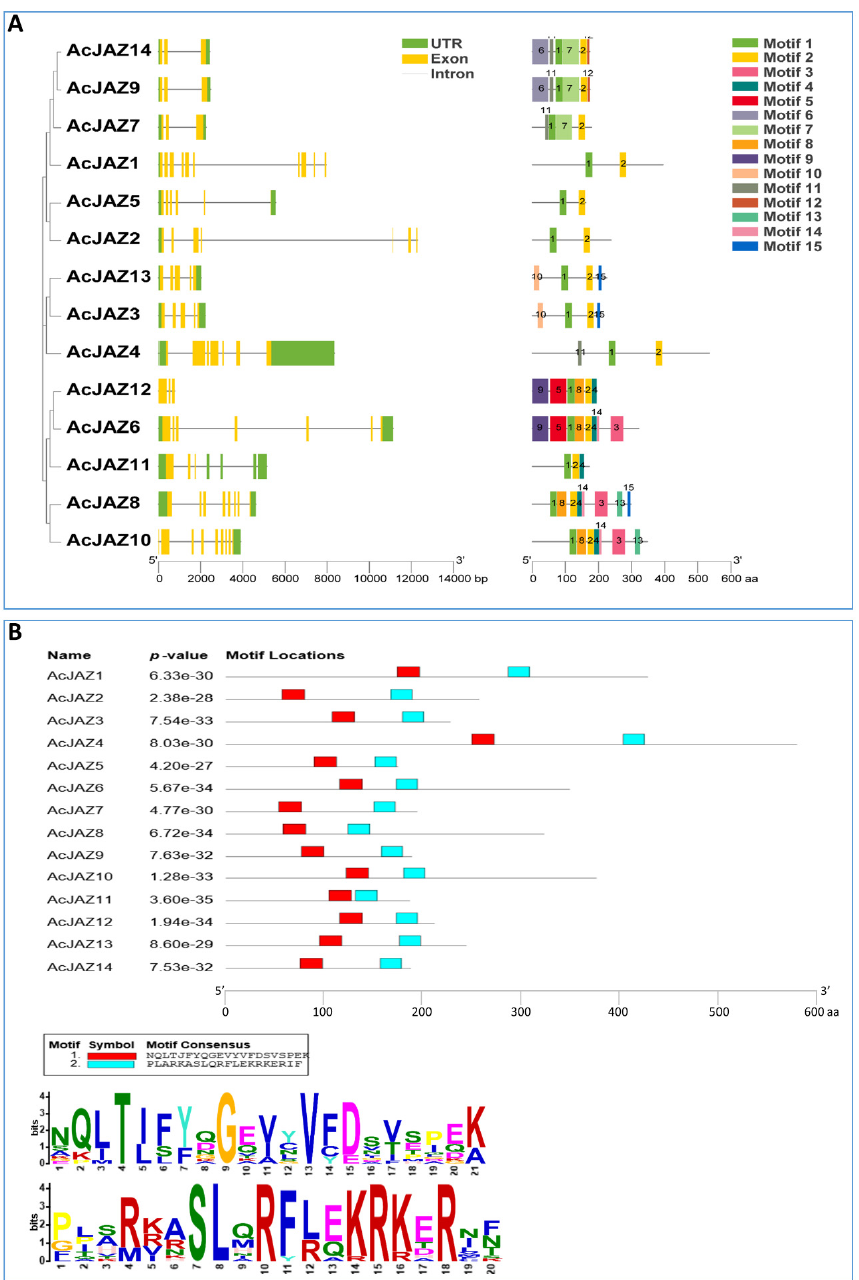
Figure 2. The JAZ proteins in pineapple. ( A ) Phylogenetic relationships, gene structures, and motifs of JAZ genes in pineapple. The first lane shows the phylogenetic tree of AcJAZ proteins generated using the neighbor-joining method with 1000 bootstrap replicates by MEGA 7. The second lane shows the exon–intron organization of AcJAZs . 5 (cid:48) and 3 (cid:48) UTRs, exons, and introns are indicated by green boxes, yellow boxes, and black lines, respectively. The scale at the bottom represents the number of nucleotides. The third lane shows the conserved motifs of Pineapple JAZ proteins detected by MEME software. Different motifs for AcJAZ proteins are indicated by different colored boxes and numbered 1–15. The scale at the bottom represents the number of amino acids. ( B ) Conserved motif 1 and motif 2 in AcJAZ proteins. The upper diagram shows the positions of conserved motif 1 and motif 2 in AcJAZs, and the scale below represents the number of amino acids. The lower diagram shows the consensus amino acids for motif 1 (the upper panel) and motif 2 (the lower panel). The height of an amino acid character indicates proportionality to the sequence